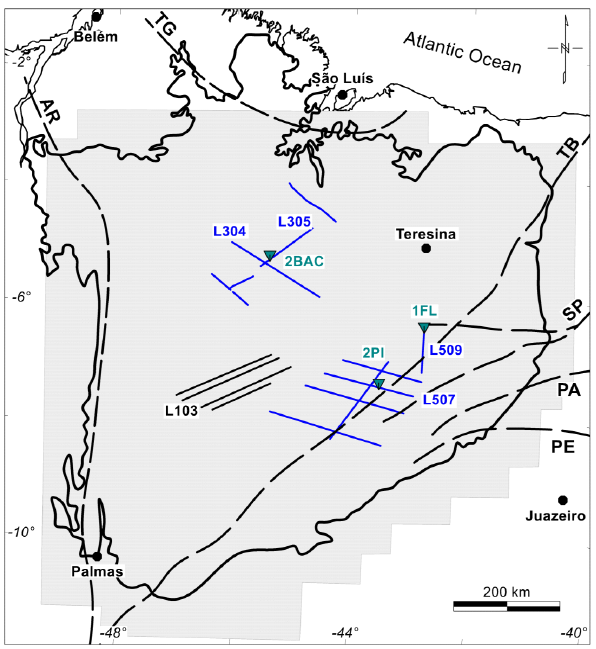
Figure 4. Location of the airborne gravity and magnetic survey (gray area), seismic profiles (blue and black) and drilling wells